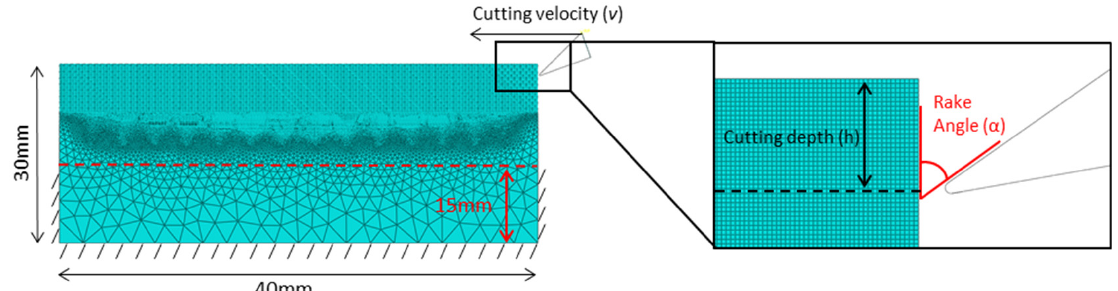
Figure 2. Finite element model dimensions, boundary conditions and discretisation of the PU workpiece. C3D8R in the tool–material contact region, C3D6 outside this region. Also illustrated is rake angle and cutting depth.